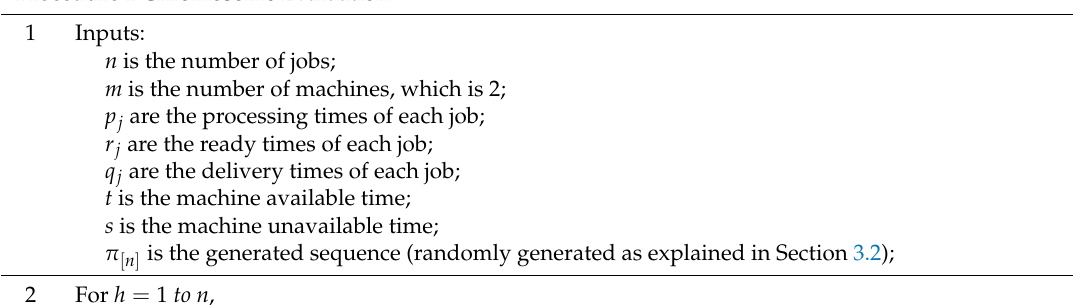
Procedure 1 Chromosome Evaluation